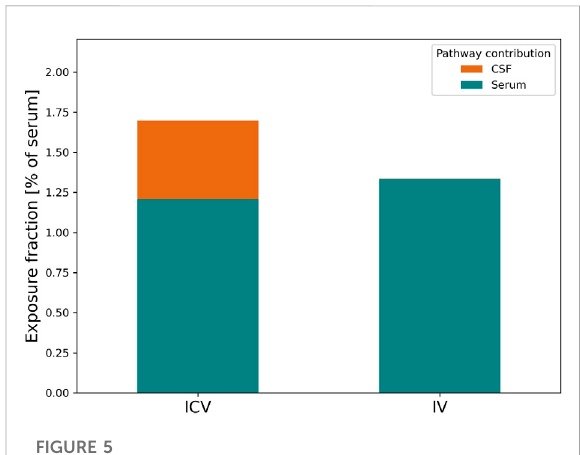
FIGURE 5 RelativecontributionofCSFandplasmapathwaystobrainISF exposure for EGFRvIII-TCB upon IV or ICV dosing. Figure 5depicts the relative contribution of antibodies originating from CSF (orange) and serum (teal) to the total ISFbrain exposure after ICV (left) or IV (right) dosing. The relative contributions are expressed as the fraction of exposure in ISFbrain relative to